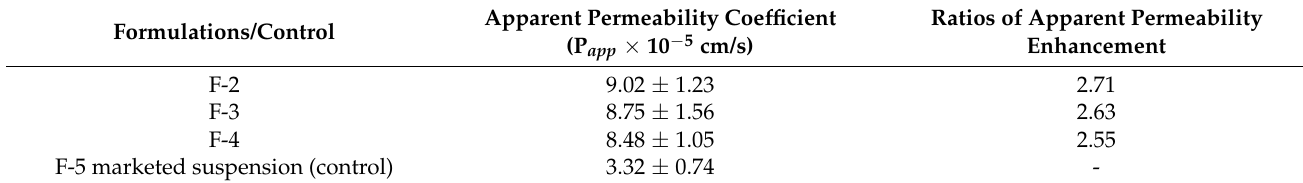
Figure 5. Ex vivo permeation studies of marketed CFX suspension F5 ( ○ ) and CFX from oily droplets F2 ( × ), F3 ( ∆ ) and F4 ( ♦ ) in PBS pH 6.8 at 37 ◦ C. Data are presented as means ( n = 3) ± SD. Table 7. Apparent permeability of cefixime across the rat intestinal membrane and enhancement ratio of F-2, F-3, and F-4 self-nano emulsion formulations compared with F-5 marketed suspension. (Mean ± SD, n =